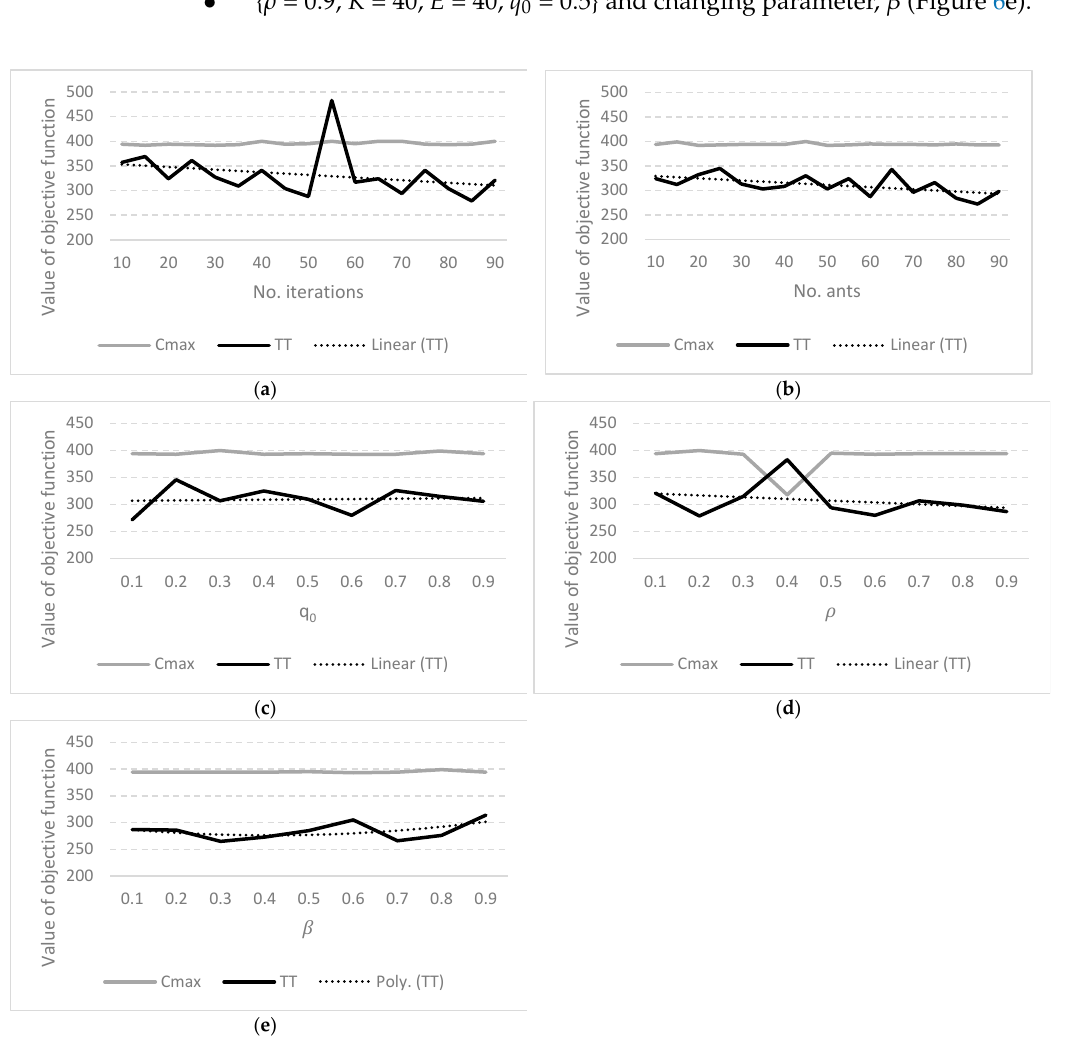
Figure 6. Results obtained by the ACO for changing parameters: ( a ) number of iterations, E; ( b ) number of ants; ( c ) q 0 ; ( d ) α = ρ and ( e ) β .